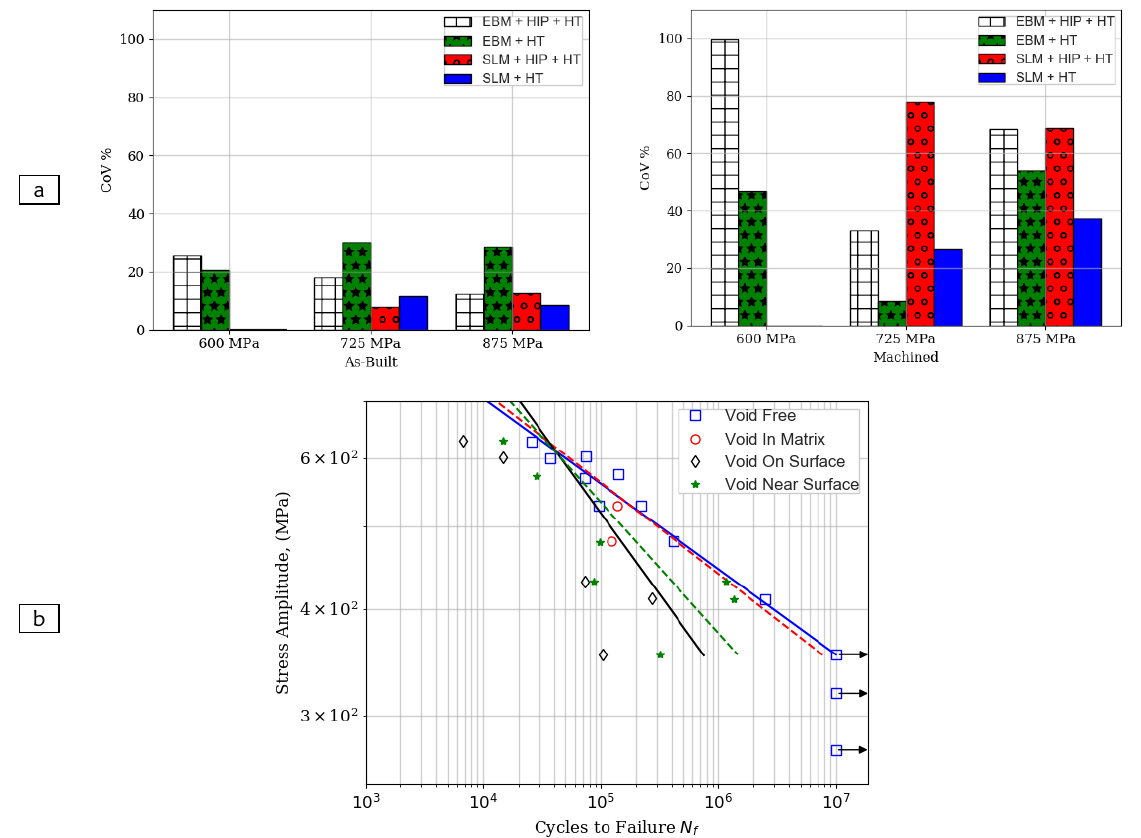
Figure 38: Scatter in fatigue life of SLM IN718 (a) Coefficient of Variance (CoV) of fatigue life for EBM and SLM IN718 at different load levels and post processing conditions [74]. (b) Effect of position of void on fatigue life of component